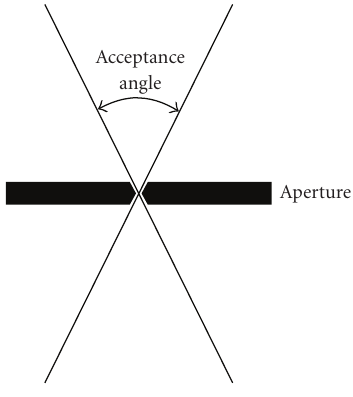
Figure 4: Illustration of acceptance angle.